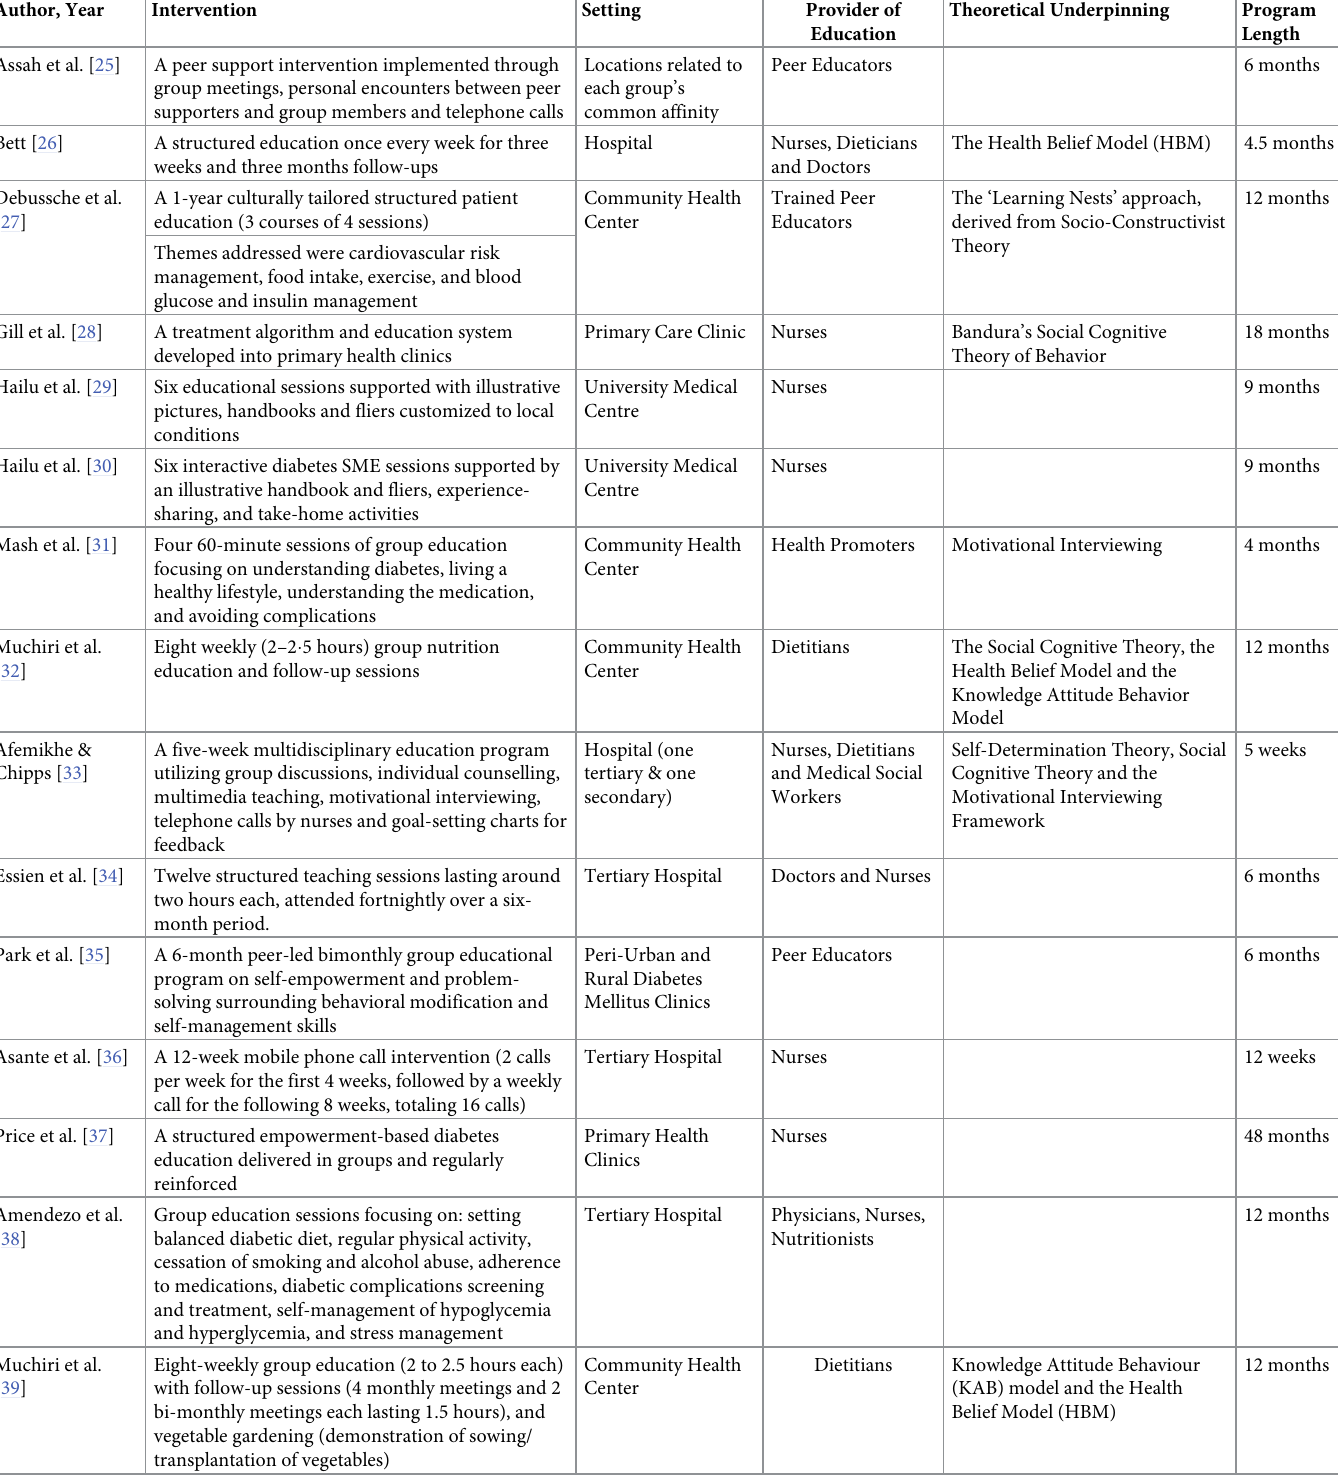
Table 3. Characteristics of the DSME